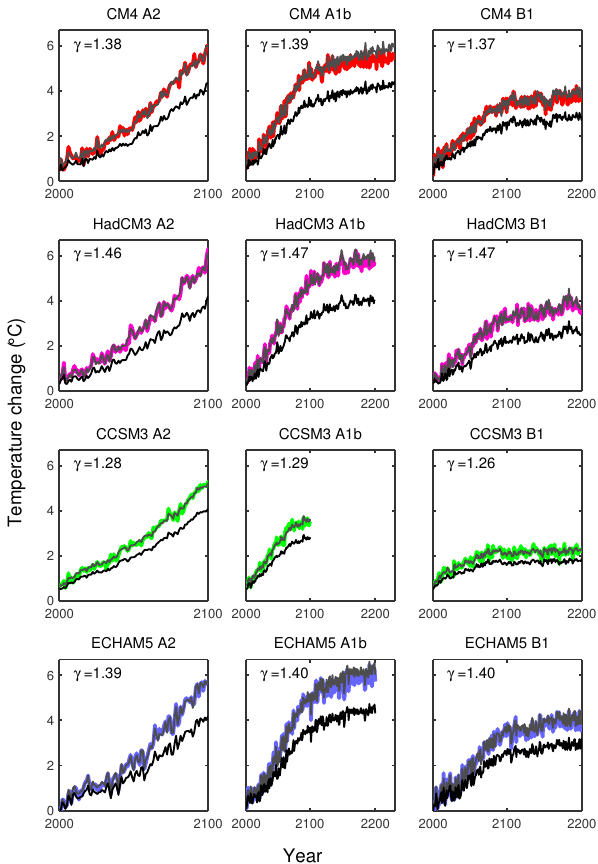
Fig. 5. Average global temperature change, 1 GT (black), average Figure 5. Average global temperature change, ∆ GT (black), average global land temperature 2 global land temperature change 1 LT (colours) and average global land temperature estimated by γ × 1 GT change ∆ LT (colours) and average global land temperature estimated by γ * ∆ GT (grey). 3